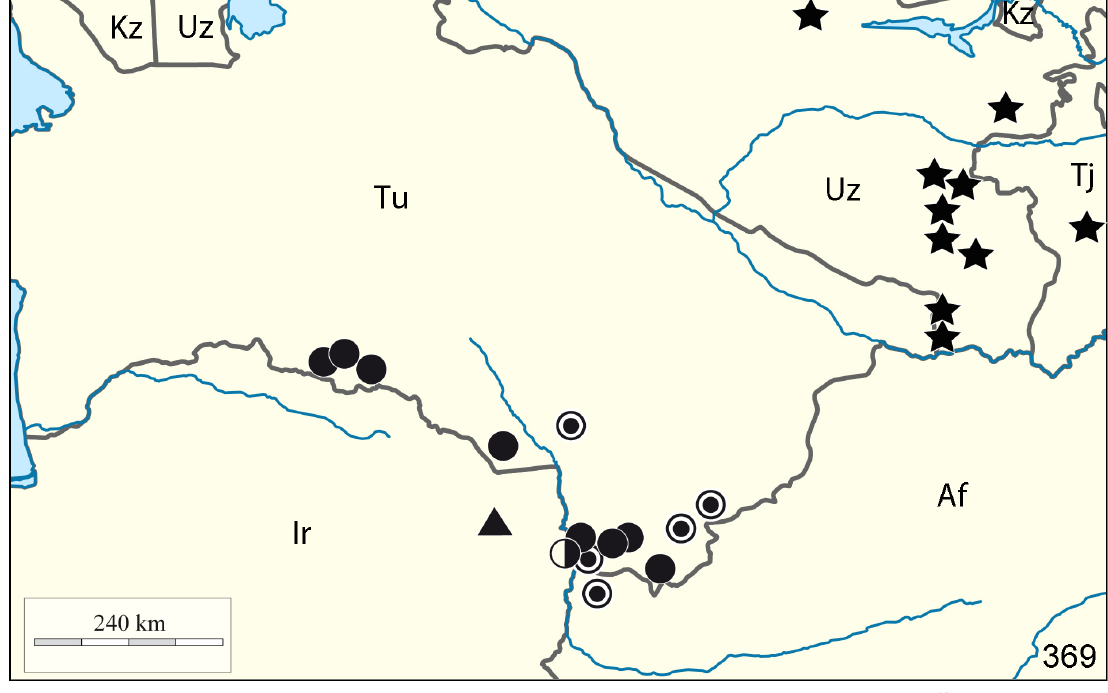
Fig. 369. Distribution of Anemesia spp. Records of A. birulai (Spassky, 1937) ( ), A. koponeni Marusik, Zamani & Mirshamsi, 2014 ( ), A. pococki sp. nov. ( ), A. tubifex (Pocock, 1889) ( ) and A. sogdiana sp. nov. ( ). Country abbreviations as in Fig.